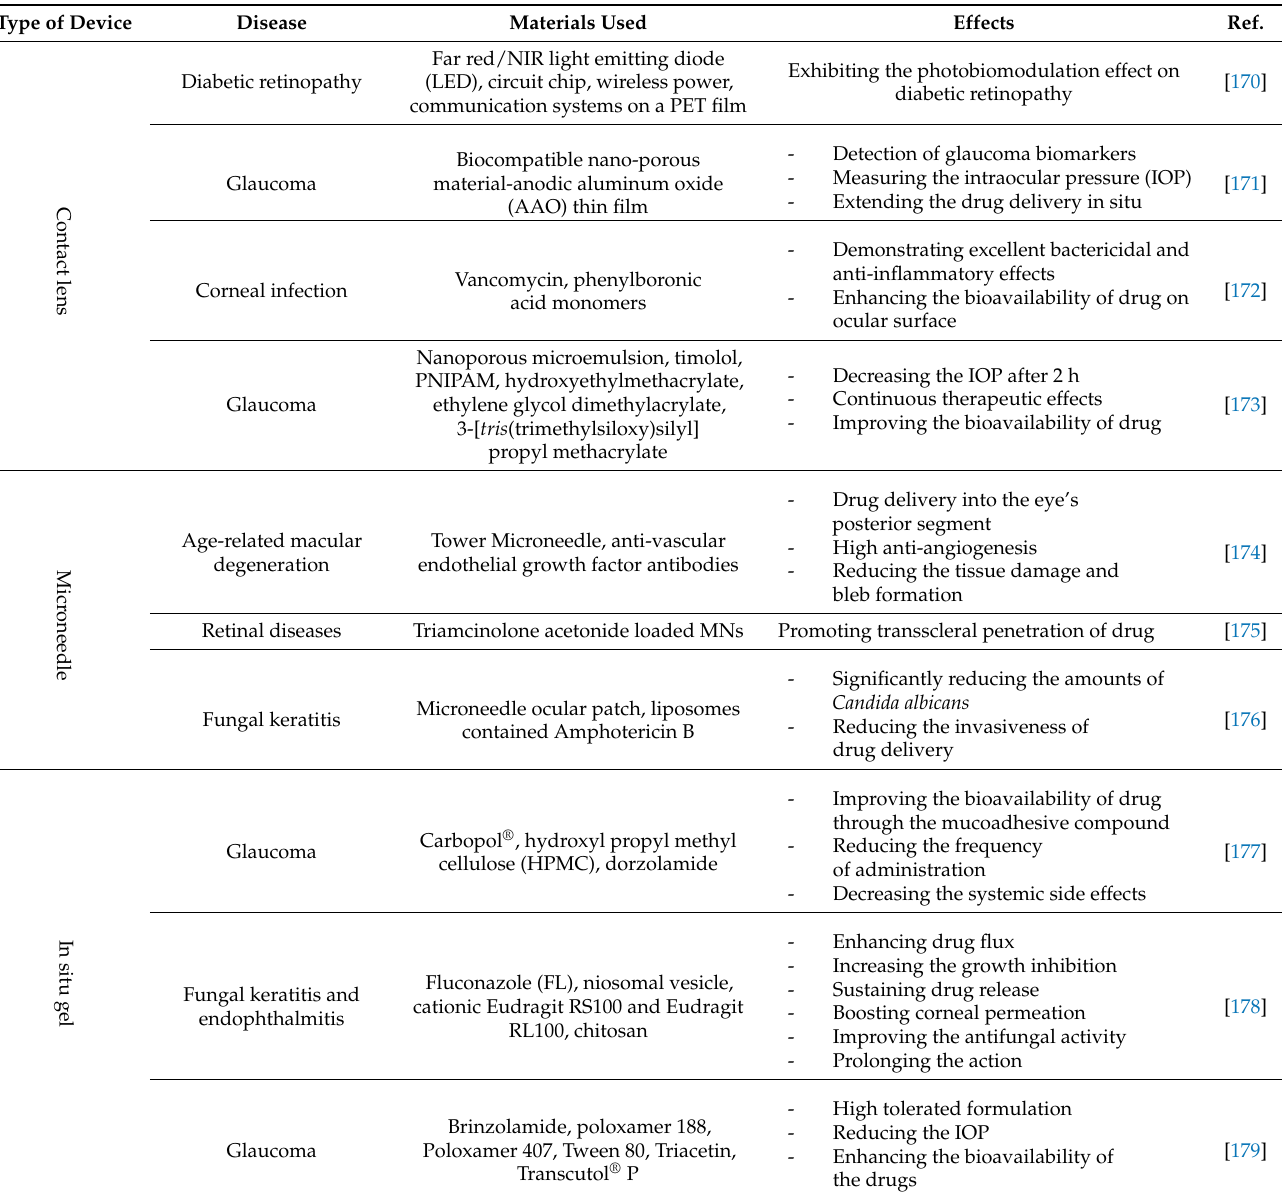
Table 3. Someofthepre-clinicalandclinicalresearchusedforthediagnosisandtreatmentofoculardisease. Type of